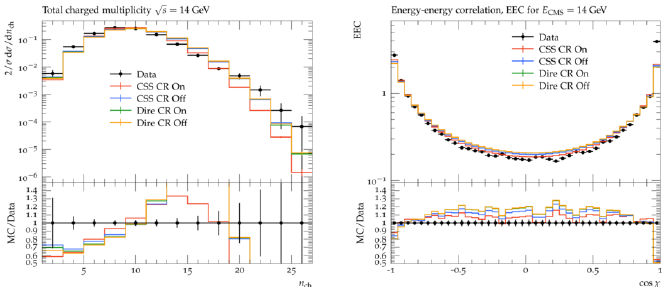
Figure 12: Charged hadron multiplicity from T ASSO [ 68 ] and energy-energy correla- tion measured by T ASSO [ 69 ] .